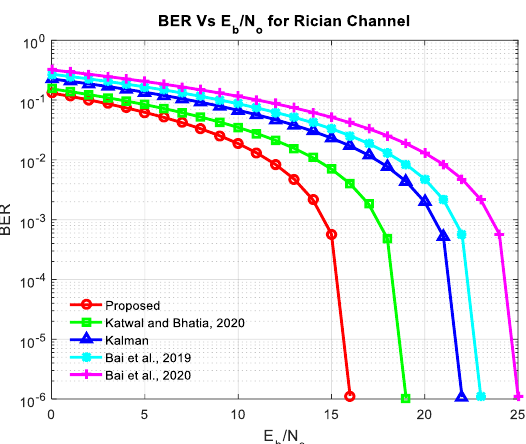
Figure 9. BER vs. E analysis for Rician channel /N b 0 Figure 9 further evaluates the effectiveness of the proposed work in terms of BER evaluated against variable energy per bit to noise ratio represented as E . In the /N b 0 case of Rician channel-based communication, the proposed work demonstrated the least BER with an average value of 0.034 as compared to 0.027 by [21], 0.023 by Kalman, 0.019 and 0.015 by Bai et al. work [42, 19]